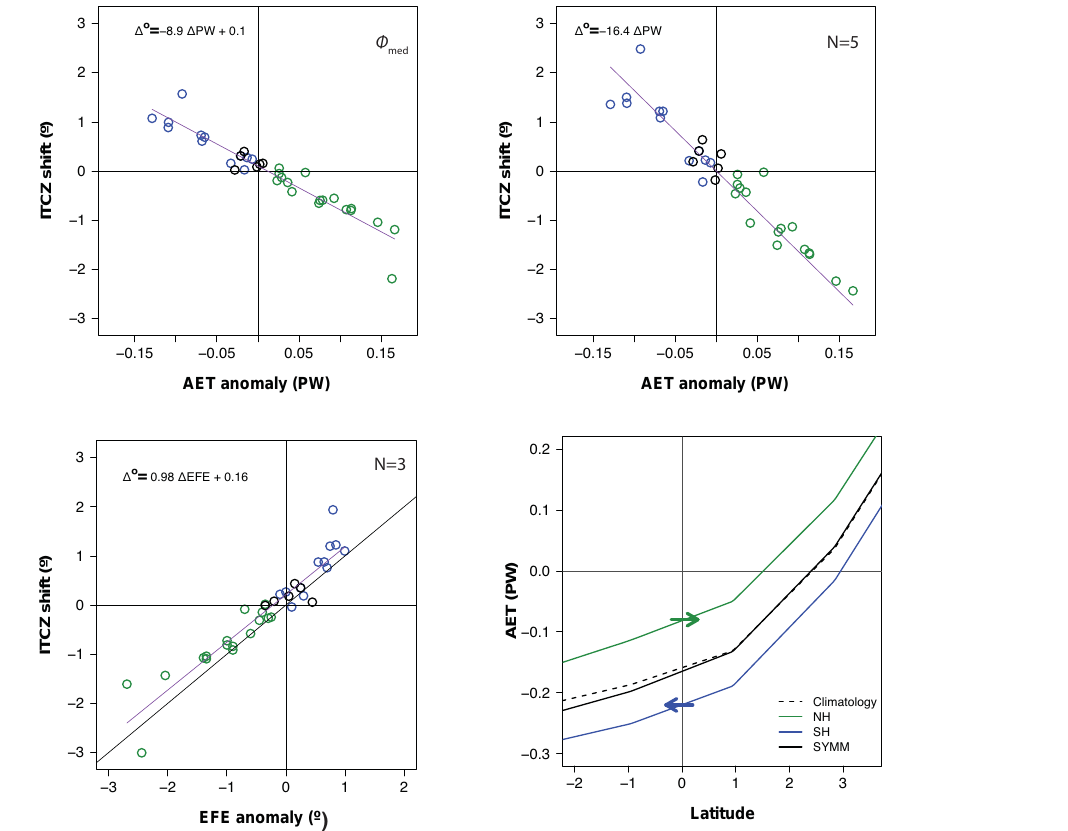
Figure 9. Annual-mean ITCZ shift represented by changes in (top left) φ med and (top right) φ ITCZ ( N = 5) vs. change in AET eq . Bottom left: changes in φ ITCZ ( N = 3) vs. change in EFE. See text for definitions. Total AET vs. latitude for a small band centered around the equator for all volcanic events in (green) ASYMM NH , (blue) ASYMM SH , and (black) SYMM cases (bottom right). Black dashed line indicates climatological or pre-eruption AET values (different choices are indistinguishable). Colored arrows represent the direction of anomalous AET eq